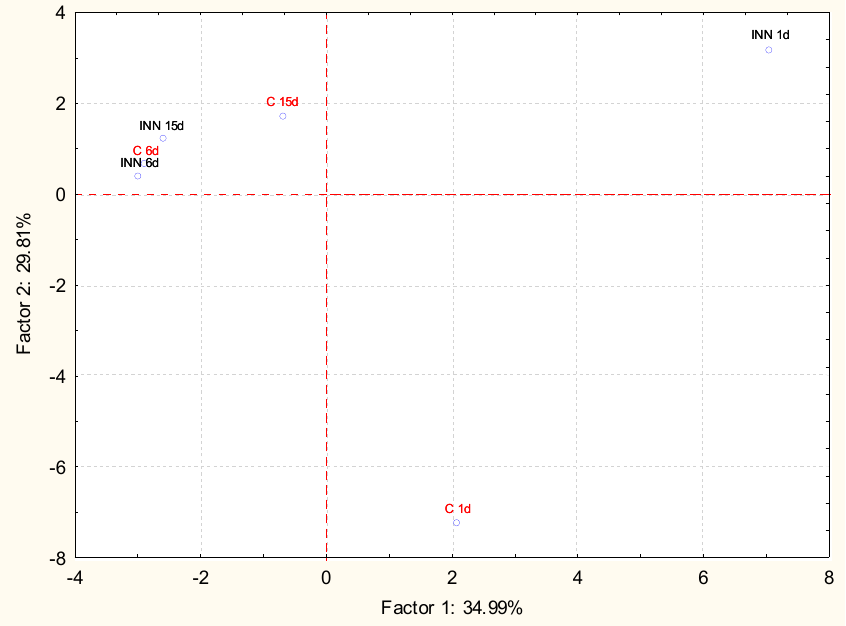
Figure 2. Projection of the different Squacquerone cheeses (INN and C) on the factor plane (1 ‐ 2) at different times of storage (1, 6, and 15 days) on the basis of the volatile profiles detected by solid ‐ phase microextraction combined to chromatography ‐ mass spectrometry technique (GC/MS SPME).